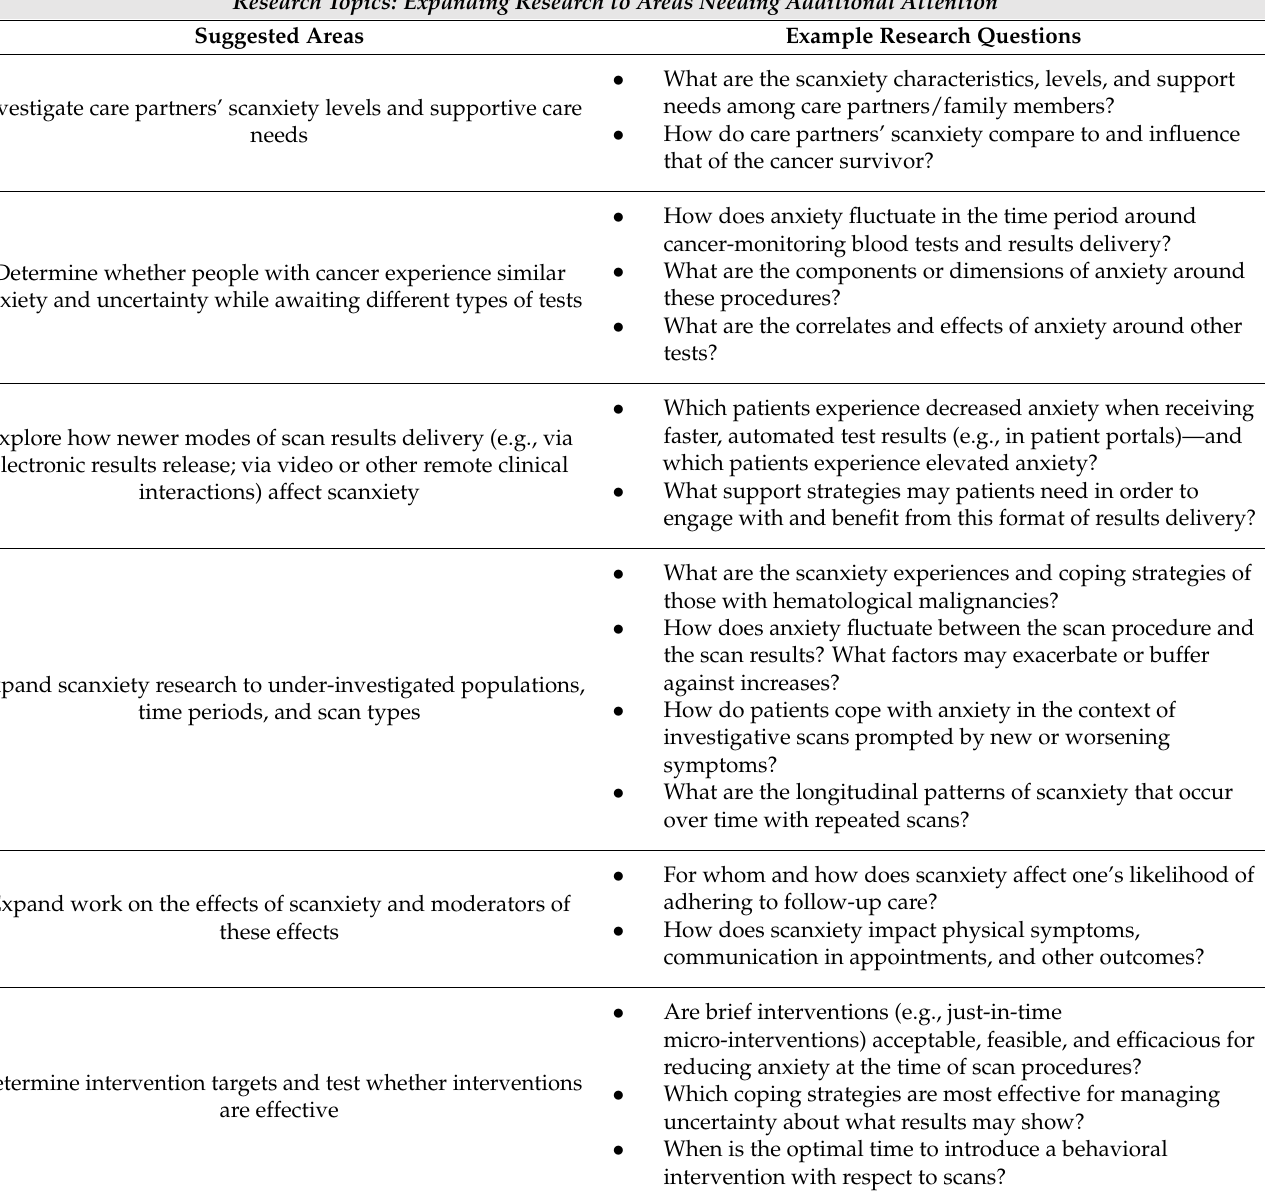
Table 5. Recommended areas for future scanxiety